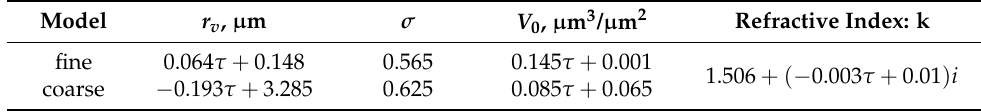
Table 3. Optical Properties of the Aerosol Models Used for Lookup Table.